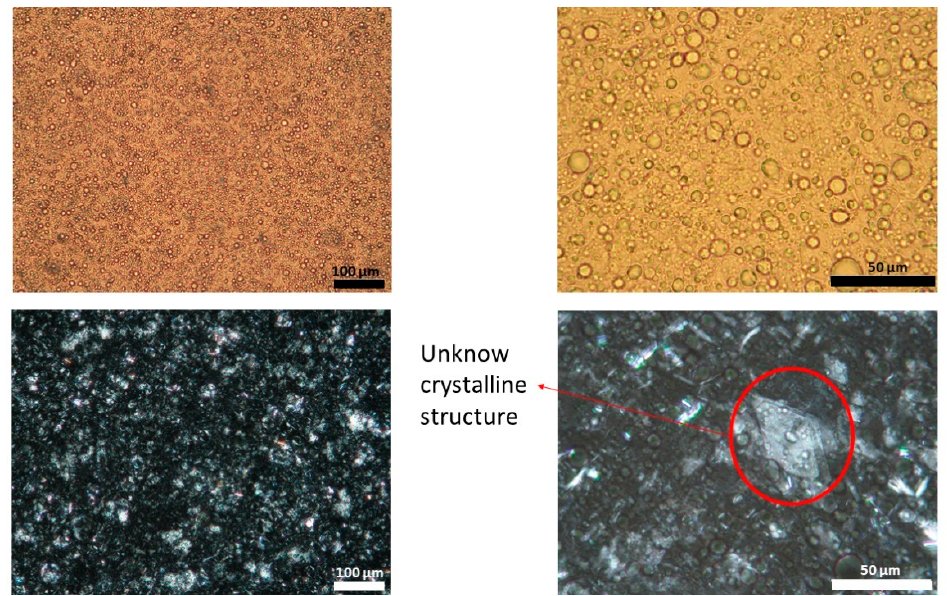
Figure 3. Light (upper panel) and polarized (lower panel) microscope images of batch three capsaicin emulsion at different magnifications. Unknown crystalline structure is highlighted. A high variability in droplet size could be observed.